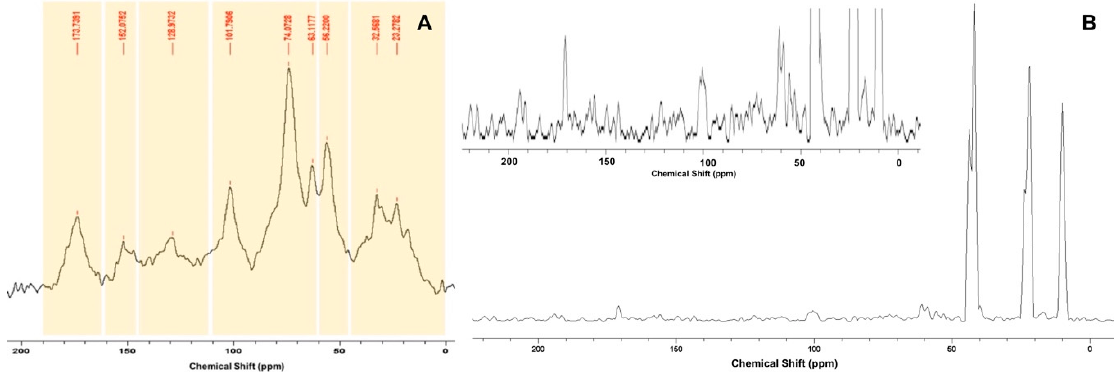
Figure 7. ( A ) 13 C-Cross Polarization Magic Angle Spinning NMR spectrum of HA, ( B ) 13 C spectrum extrapolated from the HSQC-HRMAS spectrum of the HA-APTS hybrid precursor.